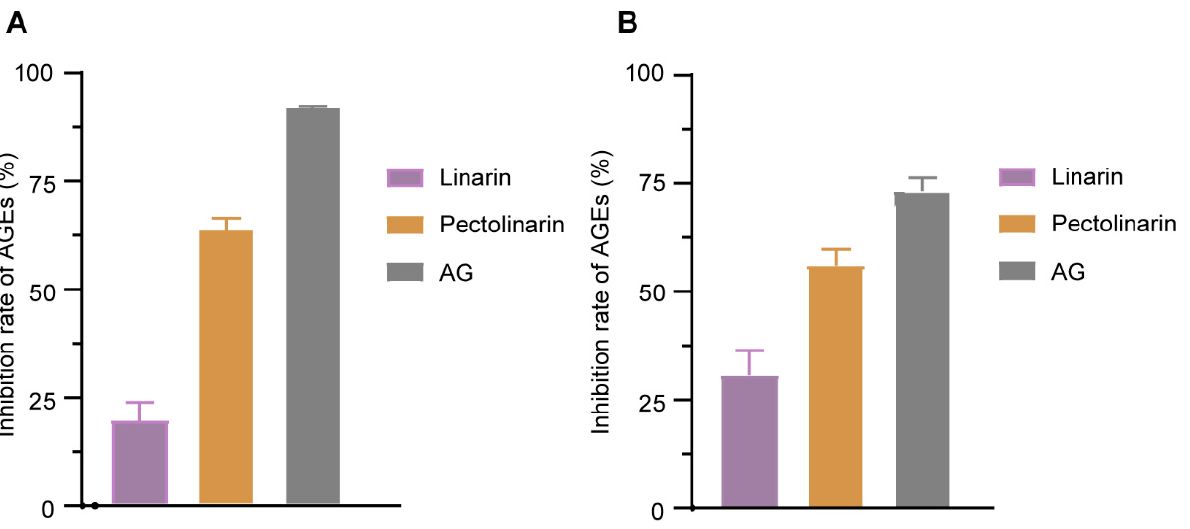
Figure 5. Pectolinarin and linarin suppress the AGEs formation. Anti-AGEs effects of pectolinarin and linarin on BSA-MGO-derived ( A ) and BSA-fructose-derived ( B ) advanced glycation end products formation at a concentration of 2 mg/mL. AGEs, advanced glycation end products.